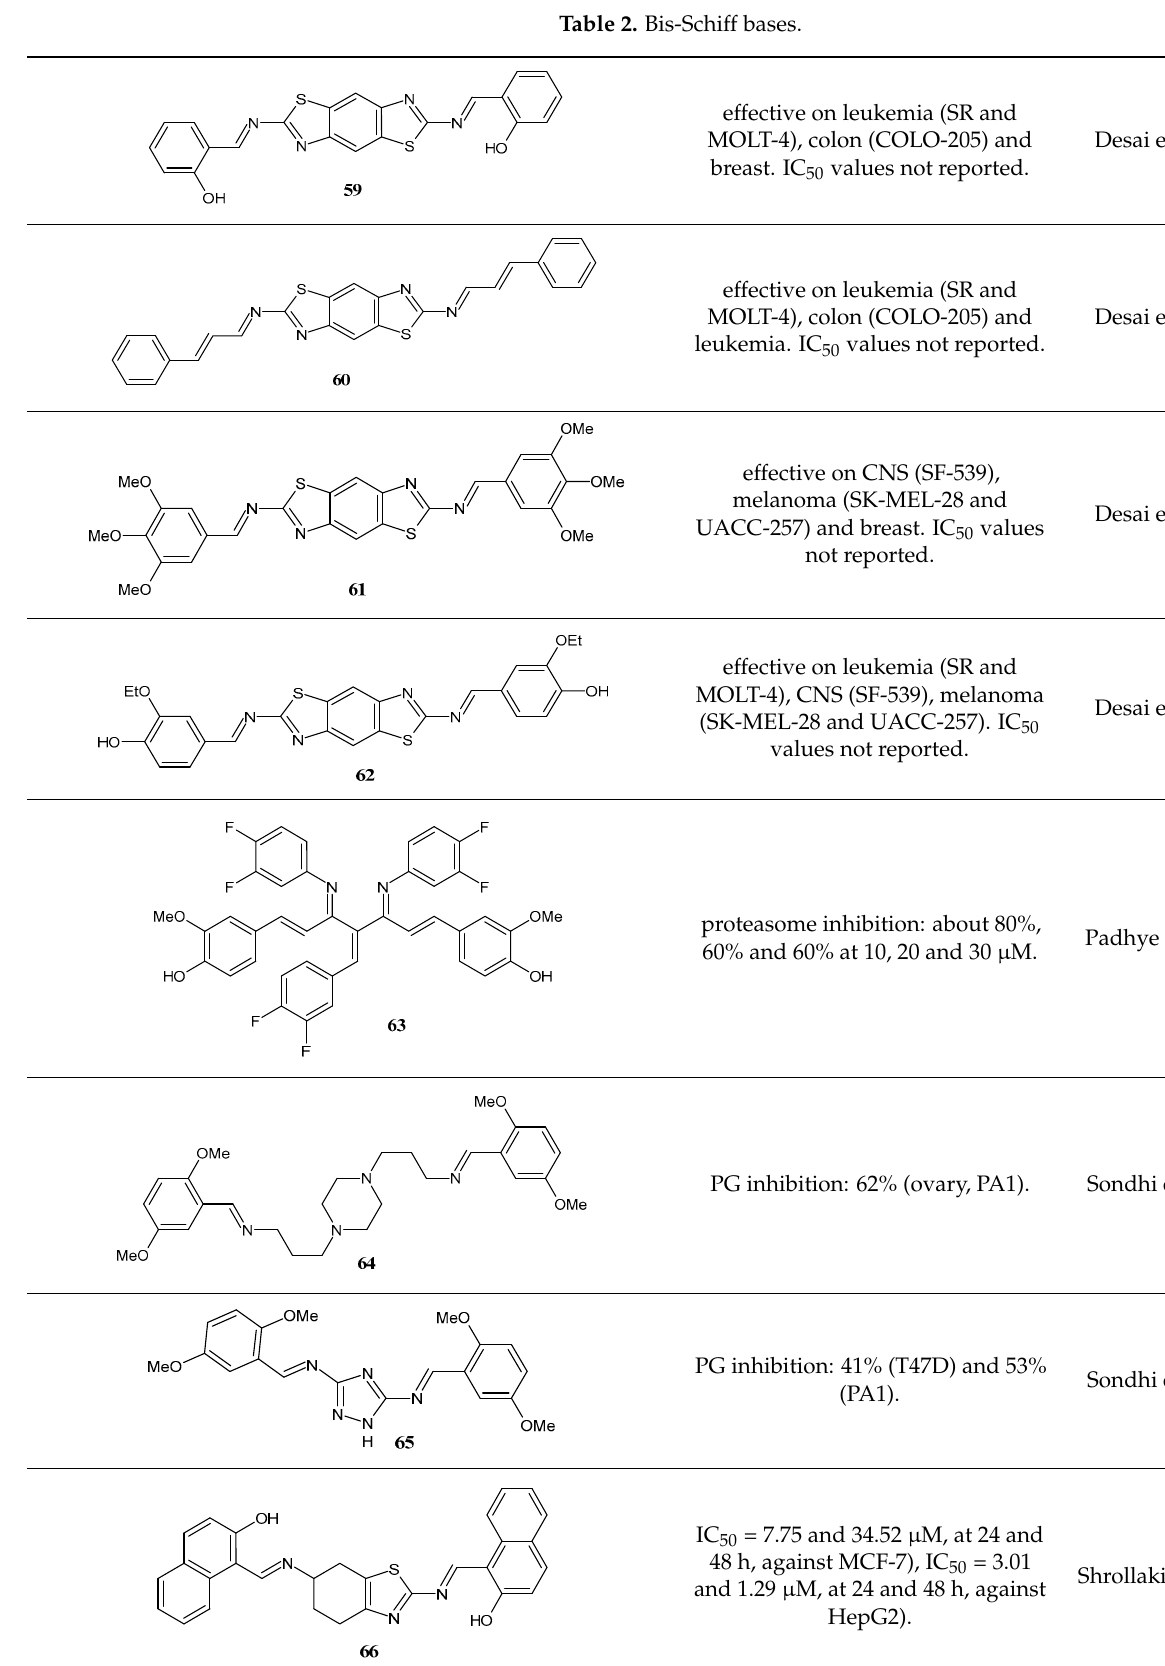
Table 2. Bis-Schiff bases.